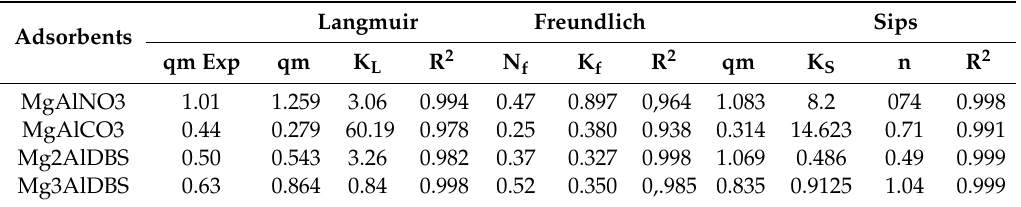
Table 4. Parameters of Langmuir, Freundlich and Sips models of Am adsorption by MgAlCO3, MgAlNO3, Mg2AlDBS and Mg3AlDBS.